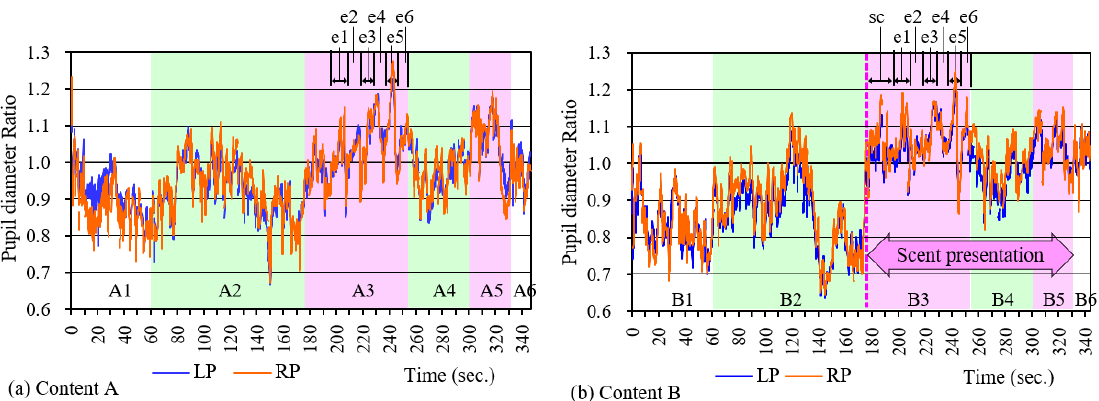
Figure 8. Example of change in pupil diameter during content viewing.